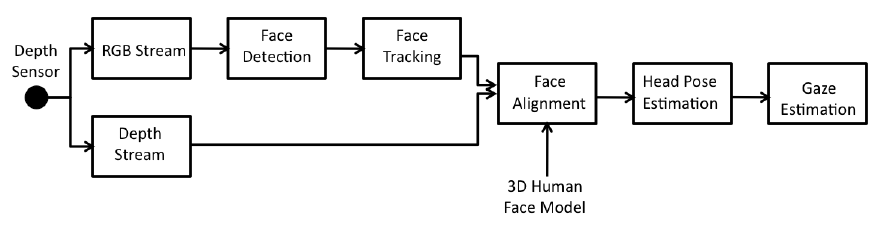
Figure 2. A schematic representation of the head pose estimation module.